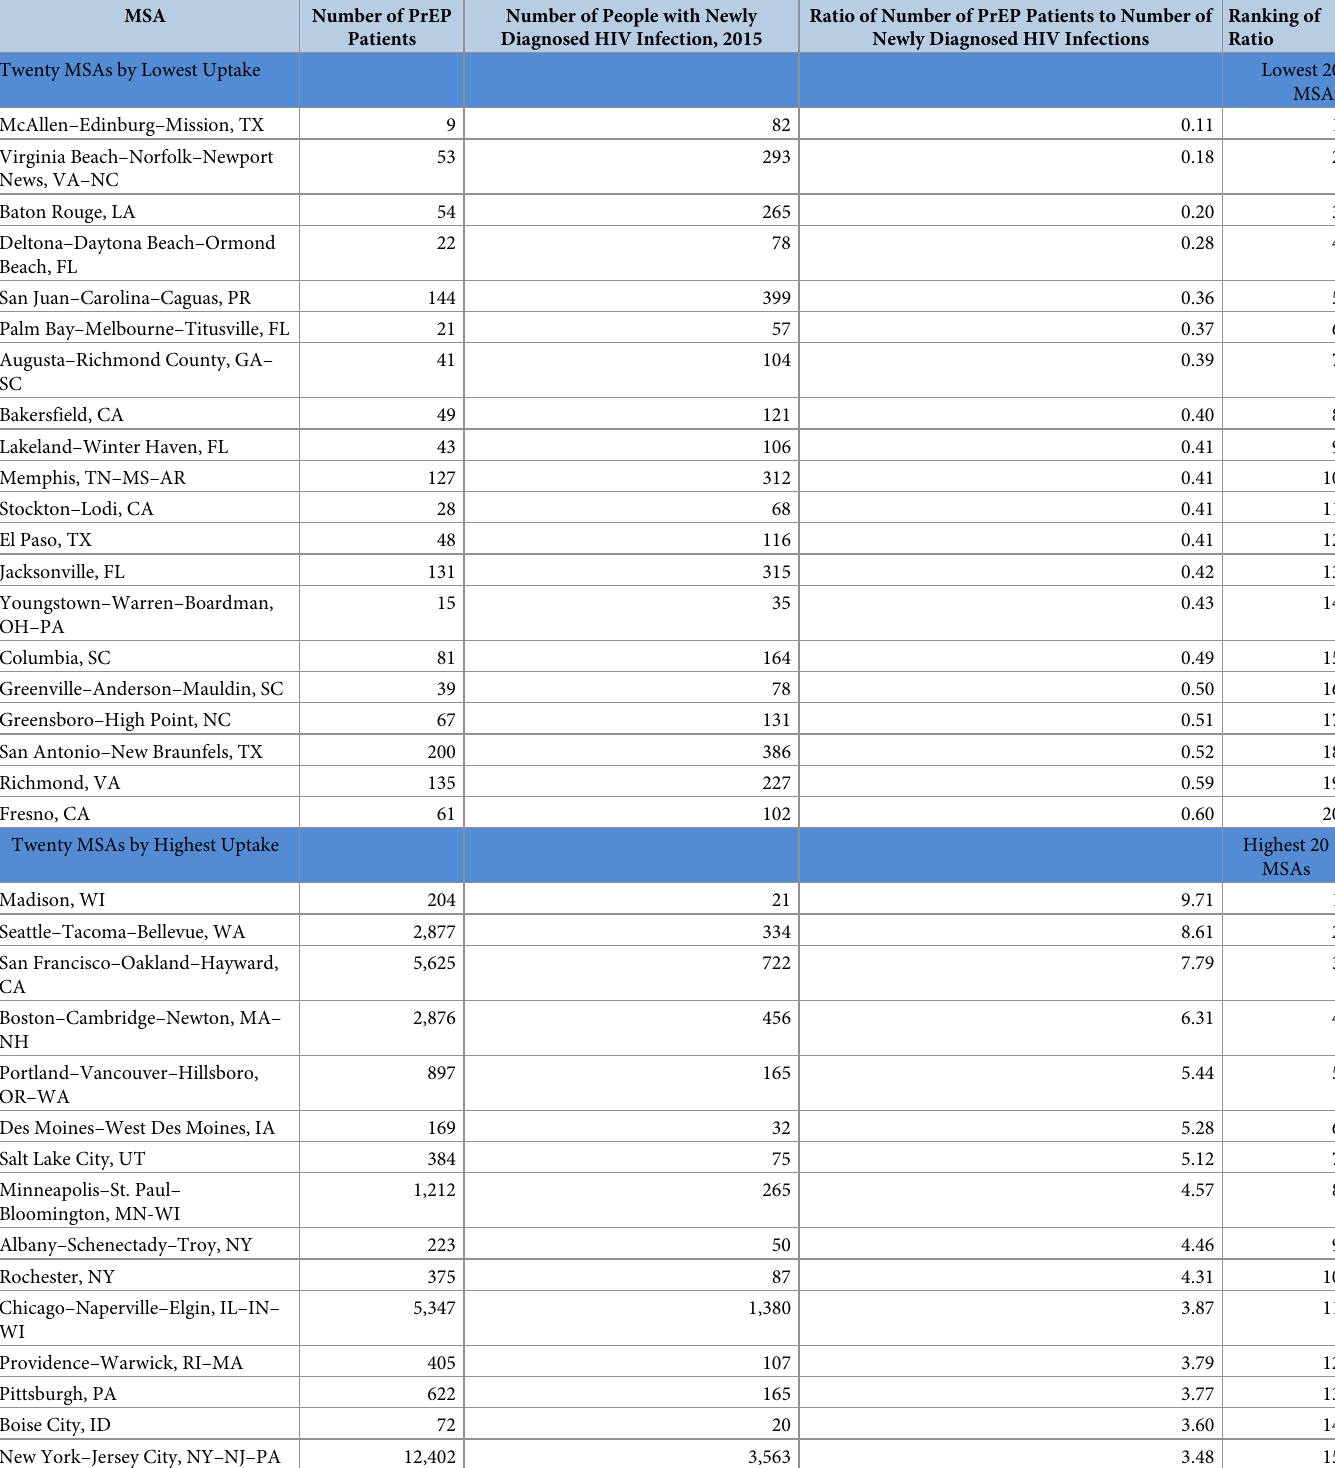
Table 2. Number of PrEP patients, number of newly diagnosed HIV infections in 2015, and ratio of relative uptake by MSA for the 20 MSAs with the lowest and highest uptake. MSA Number of PrEP Number of People with Newly Ratio of Number of PrEP Patients to Number of Ranking of Patients Diagnosed HIV Infection, 2015 Newly Diagnosed HIV Infections Ratio Twenty MSAs by Lowest Uptake Lowest 20